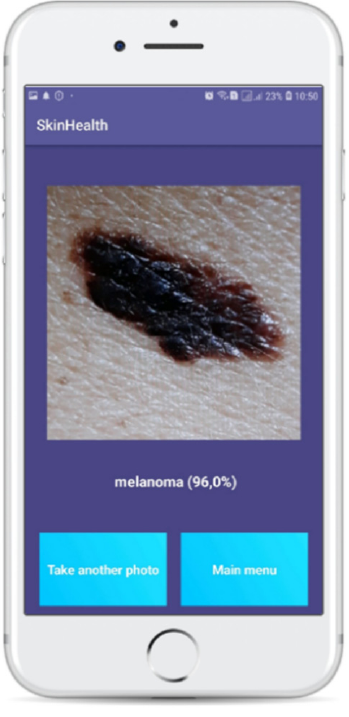
Figure 6. Application screenshot: classification result.